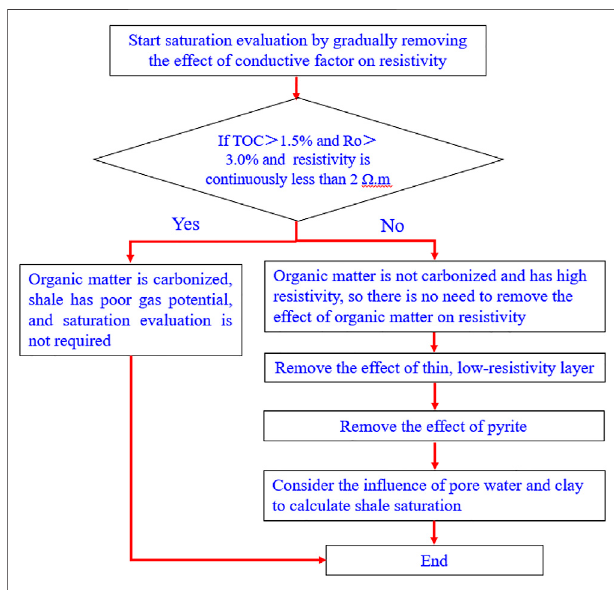
FIGURE15 | Flow chart ofthe new procedure withstepwisestripping of conductivity in fl uencing factors.